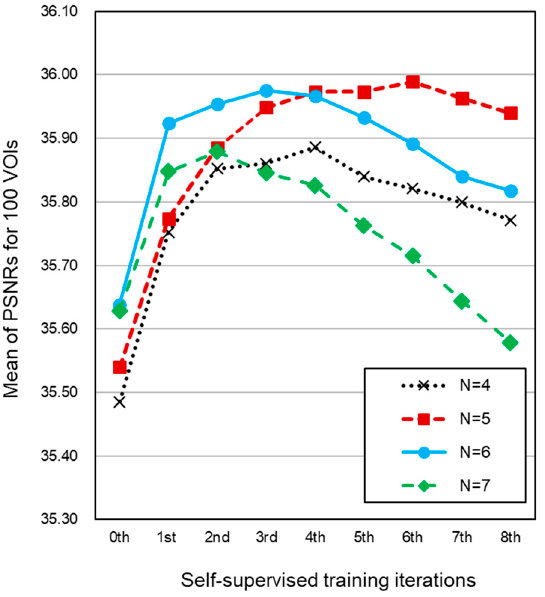
Figure 3. The mean value of the PSNR over 100 VOIs that were extracted from the fecal-tagging anthropomorphic colon phantom that was cleansed virtually by use of the proposed self-supervised 3D-GAN EC scheme. The values are shown for the initial supervised learning step and for the subsequent self-supervised training iterations for different numbers of convolutional and deconvolutional layers (N) of G . A high PSNR value indicates a higher cleansing quality than a low value.